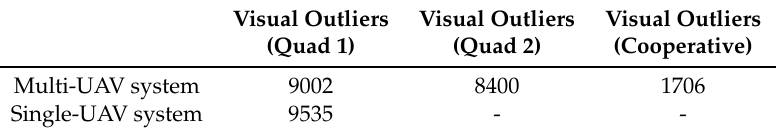
Table 3. Number of failures introduced into the